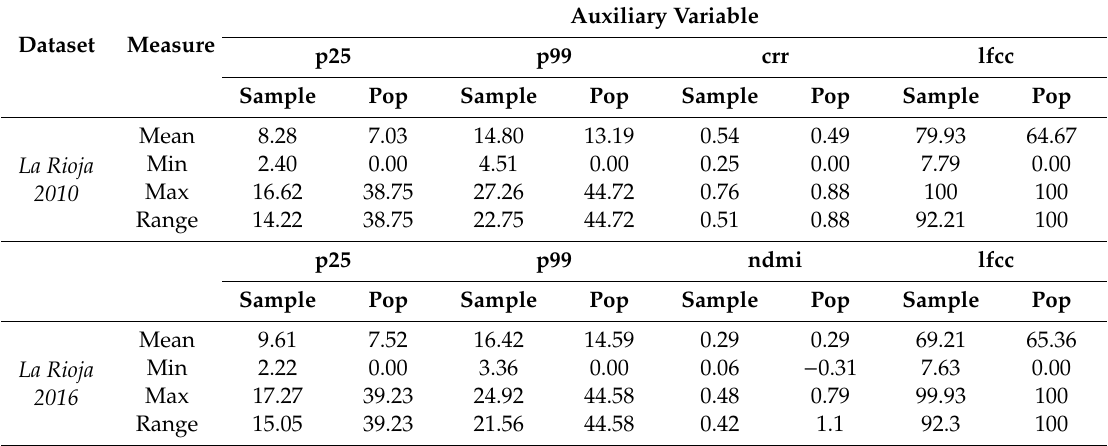
Table 3. Ranges of the auxiliary variables in the sample and the population (Pop) for La Rioja 2010 and La Rioja